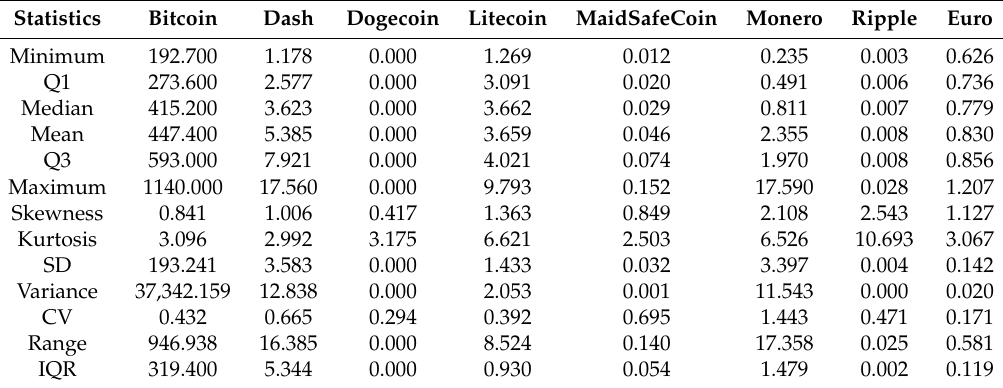
Table 1. Summary statistics of daily exchange rates of Bitcoin, Dash, Dogecoin, Litecoin, MaidSafeCoin, Monero, Ripple and Euro, versus the U.S. Dollar from 23 June 2014 until 28 February 2017.